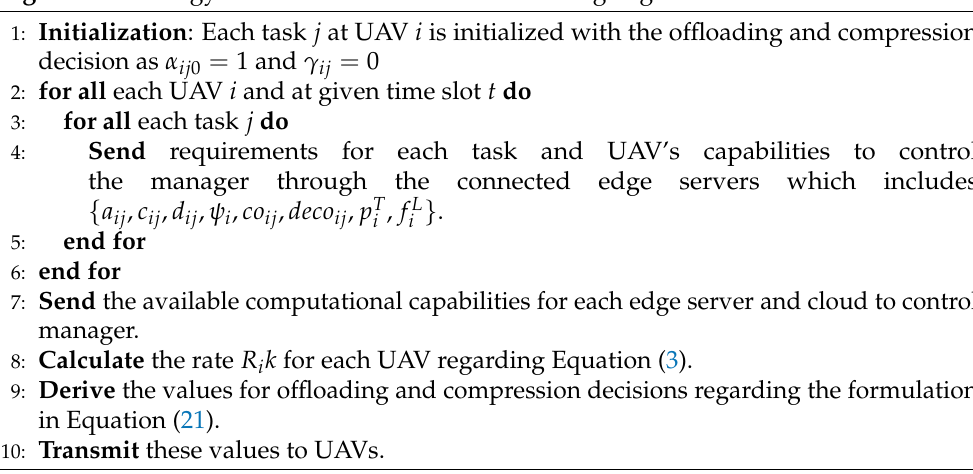
Algorithm 1 Energy-Aware and Secure Task Offloading